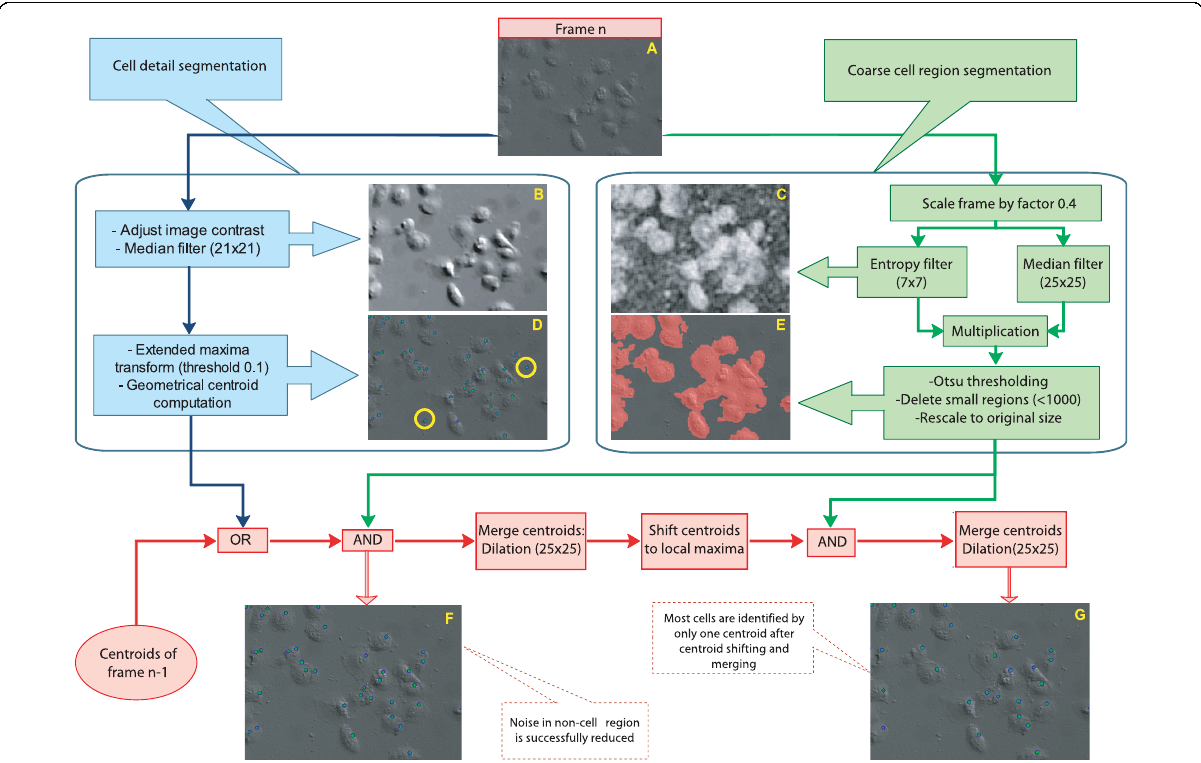
Figure 2 Cell centroid segmentation . Schematic workflow and examples of intermediary steps of cell centroid extraction from microscopic images. Each new frame (A) will be processed in two distinct steps, namely cell detail segmentation (left, blue box) and cell region segmentation (right, green box). The detected centroids from the detail segmentation are first combined with the extracted centroids of one past frame to propagate cell centroids steadily through an image sequence. Afterwards the combination of the cell region image and the cell centroid image leads to deletion of cell positions in non-cell regions (panel F). Subsequent centroid merging and shifting finally concentrate groups of possible centroids within one cell to form a single cell centroid (panel G).